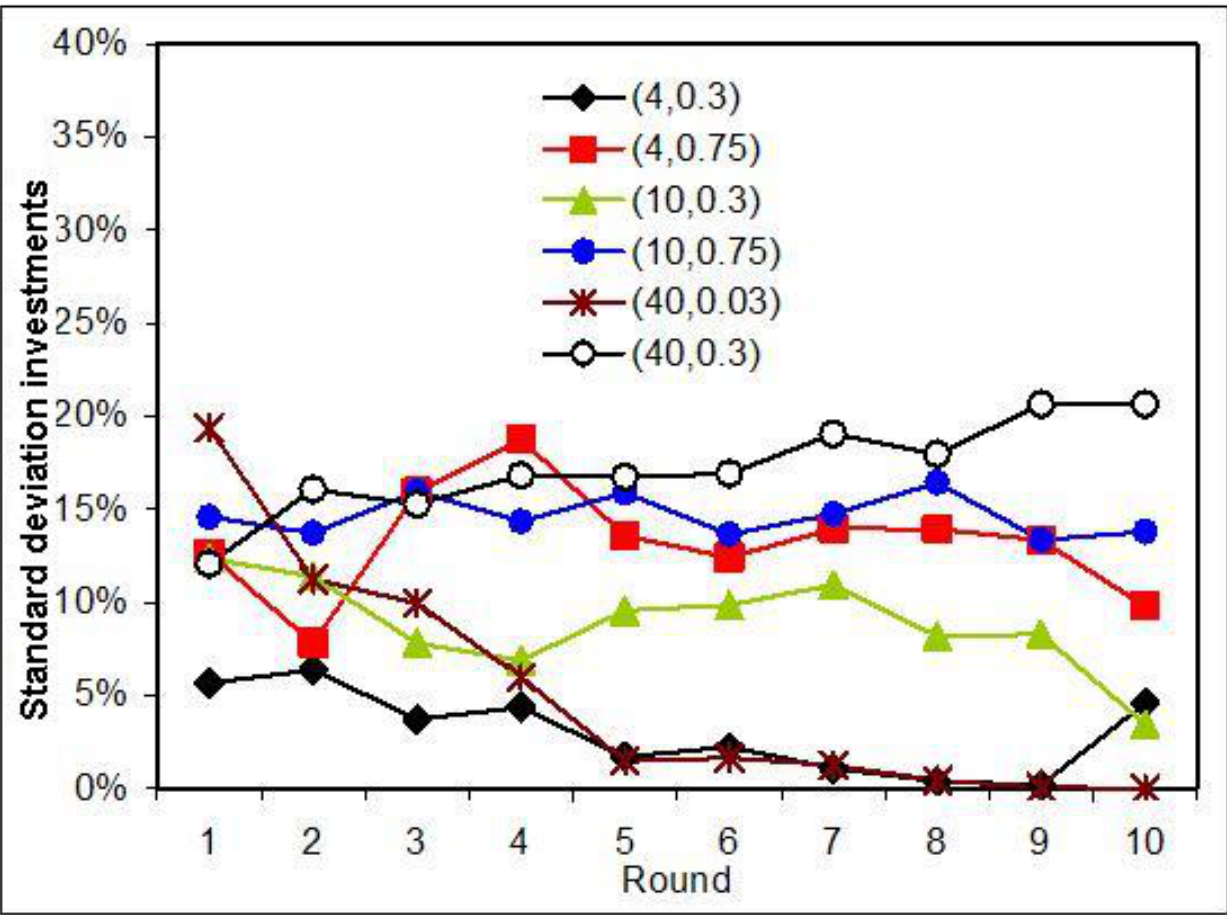
Fig. 4 . Average standard deviation of the contribution level within a group for the six different treatments. The number of participants and the marginal per capita return are given in